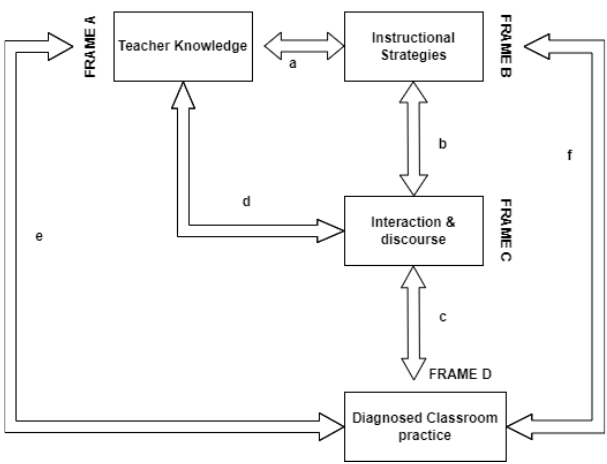
Figure 1: Classroom practice diagnostic framework (CPDF); Source: Mudau, 2013.